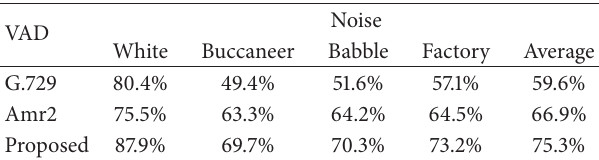
Table 1: Average speech/nonspeech hit rates under different noise conditions at 5 dB.